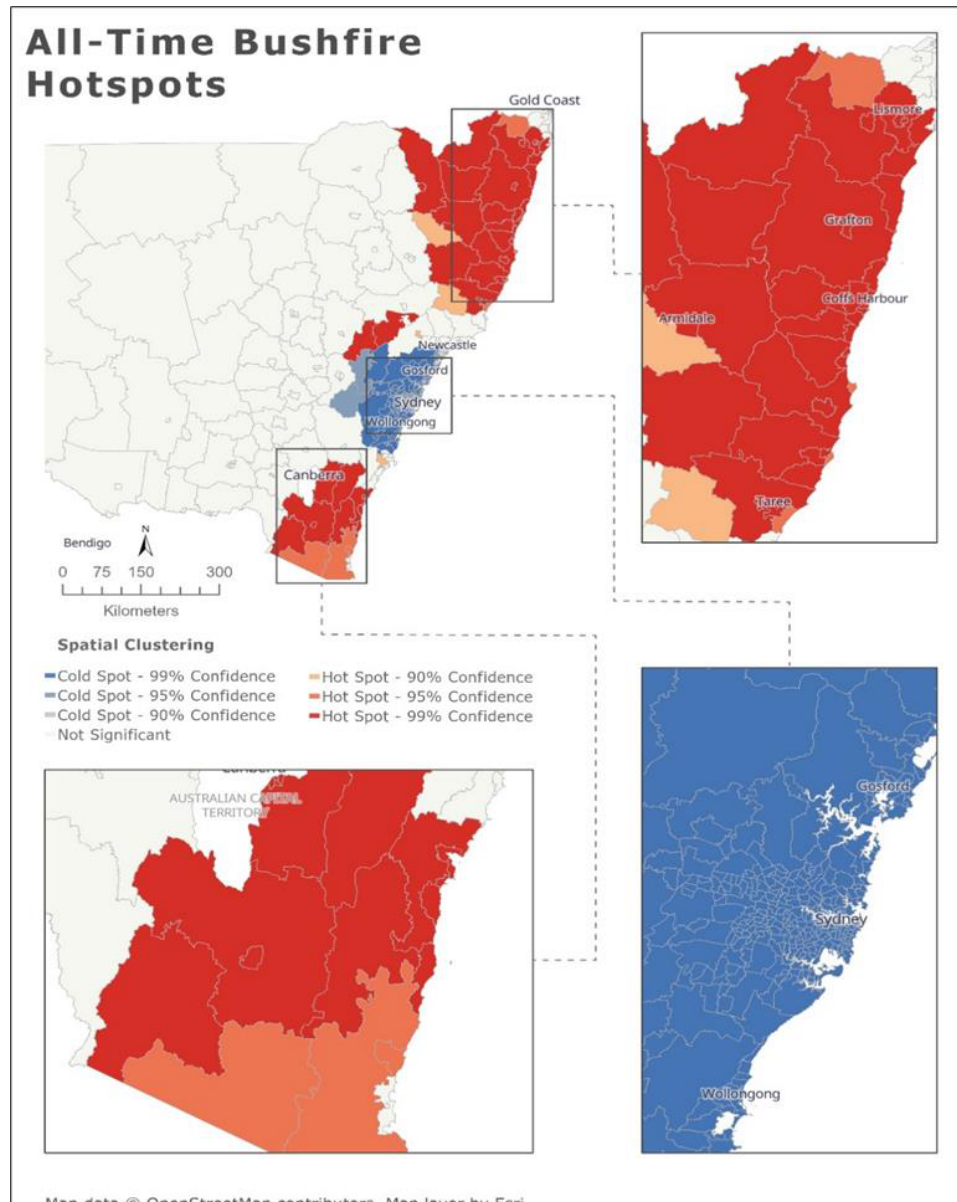
Figure 13. Hotspot analysis of the number of bushfires by statistical area level 2 in NSW.